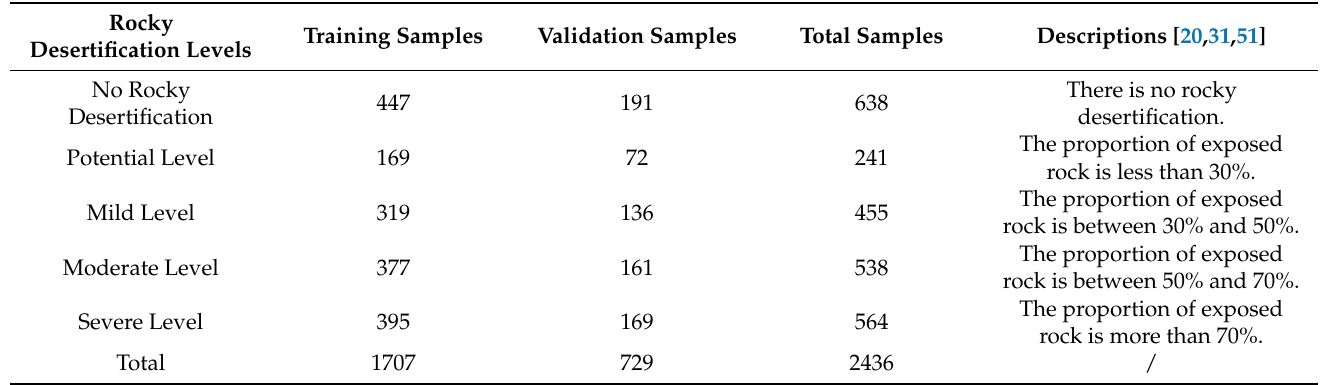
Table 3. Samples and descriptions of rocky desertification